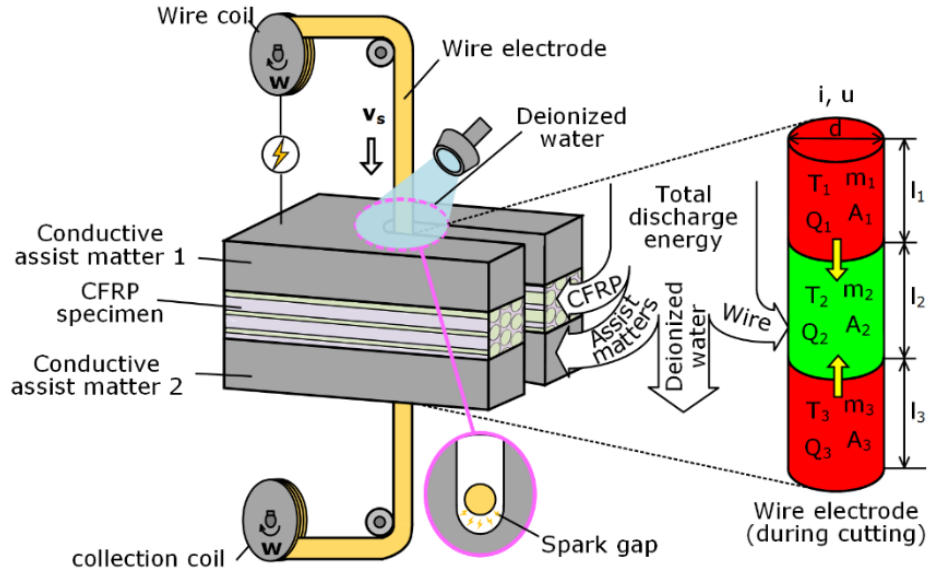
Figure 9. Schematics of the proposed preheating-assisted WEDM technique (Reprinted with permission from Ref. [121]. 2020, copyright Elsevier B.V.).